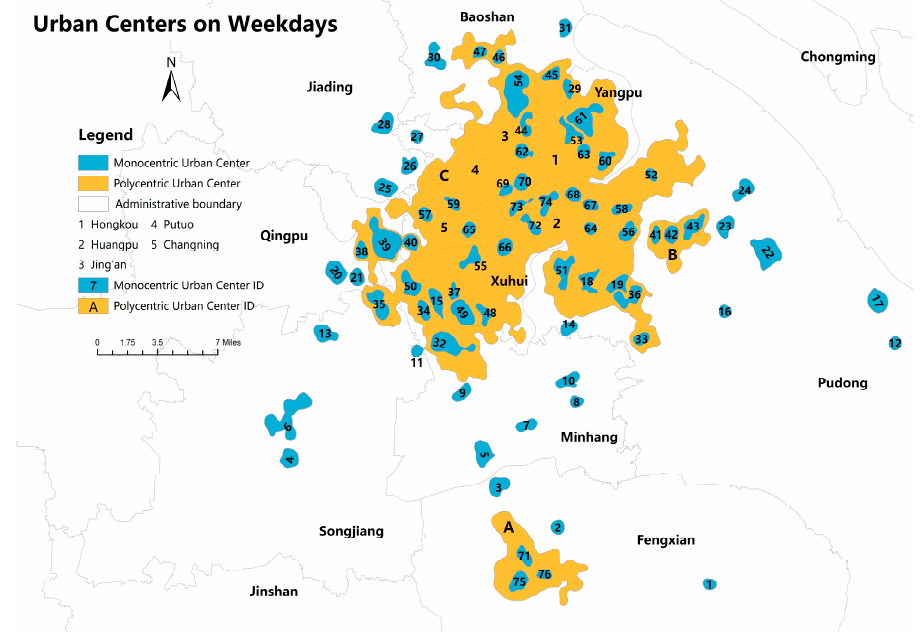
Figure 8. Urban centers on weekdays.